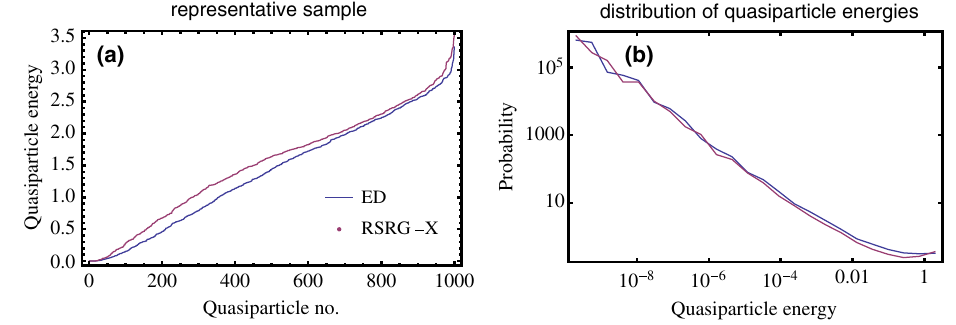
FIG. 5. (a) Comparison of the single quasiparticle spectrum for a representative 1000 spin hJ chain at criticality computed using RSRG-X and exact diagonalization (ED). (b) Comparison of the distribution of quasiparticle energies obtained using RSRG-X and ED for the hJ model. The data were obtained from 50 disorder realizations of 1000 spin chains at